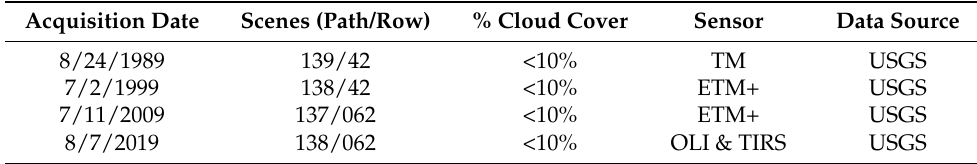
Table A1. Details of the Landsat images used for land use/land cover mapping during our study in